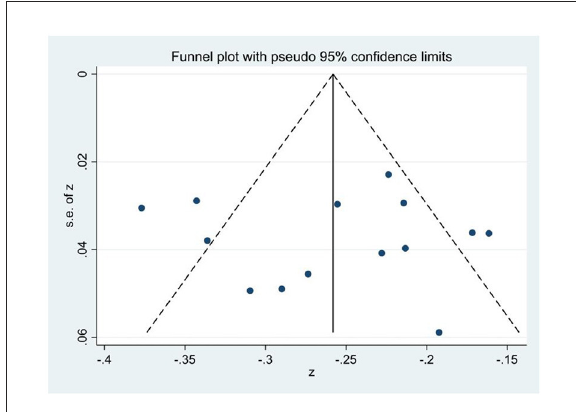
FIGURE4 Funnel plot of the correlation of smartphone addiction and social